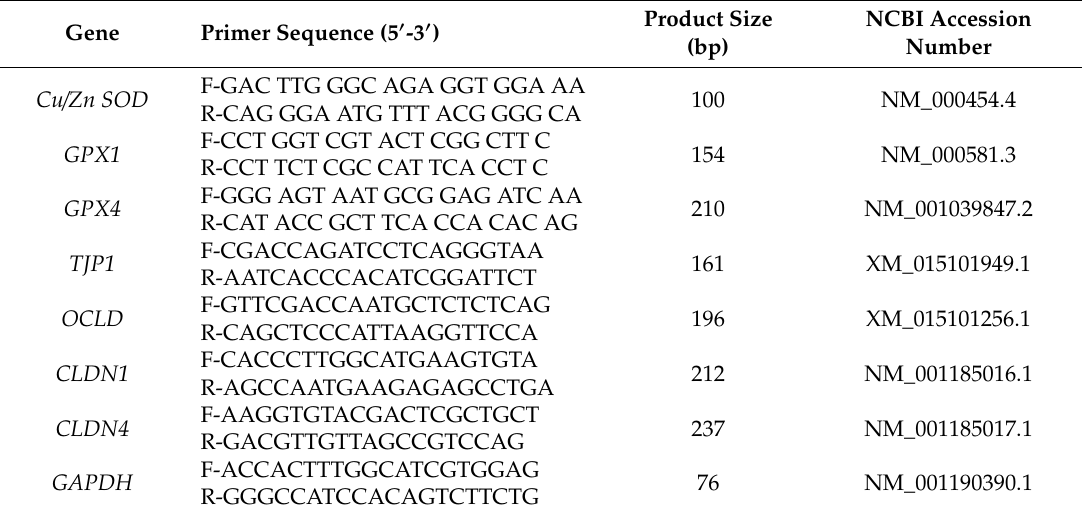
Table 2. Primer information of reference and target genes.